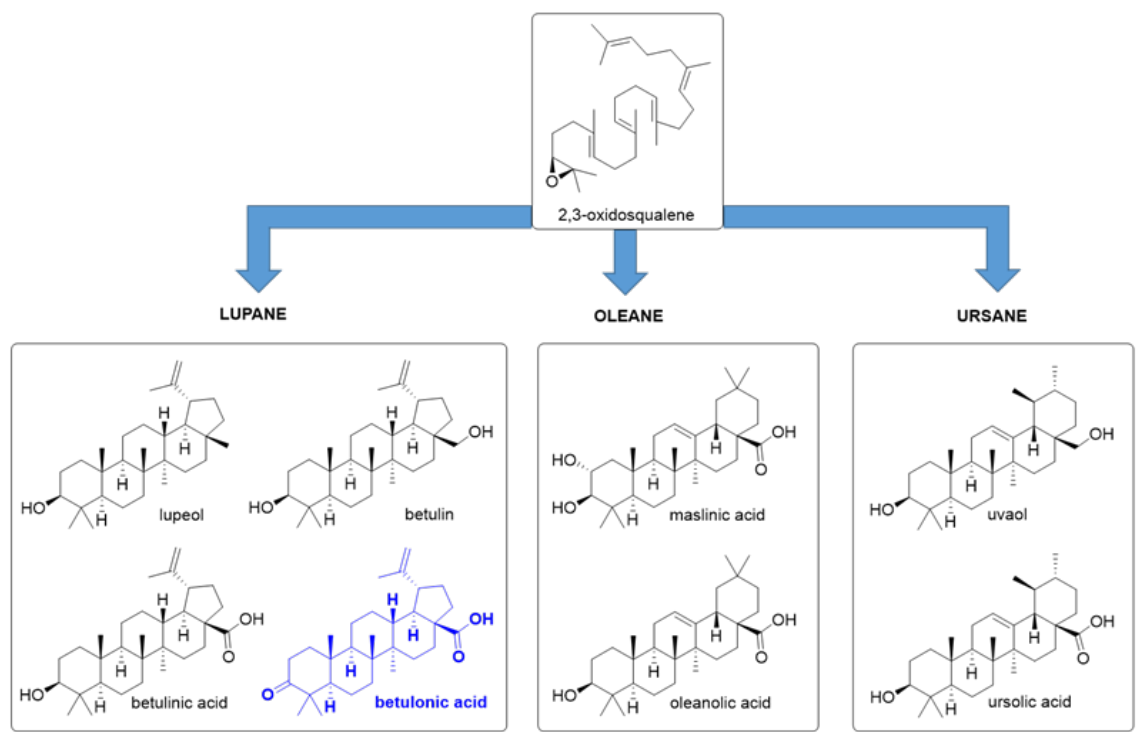
Figure 1. Biologically active pentacyclic triterpenoids in the management of different types of can- cer.